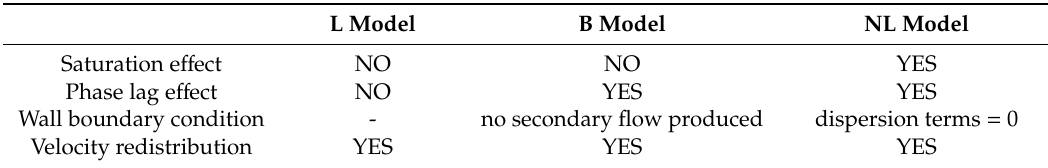
Table 1. Di ff erences between L, B, and NL